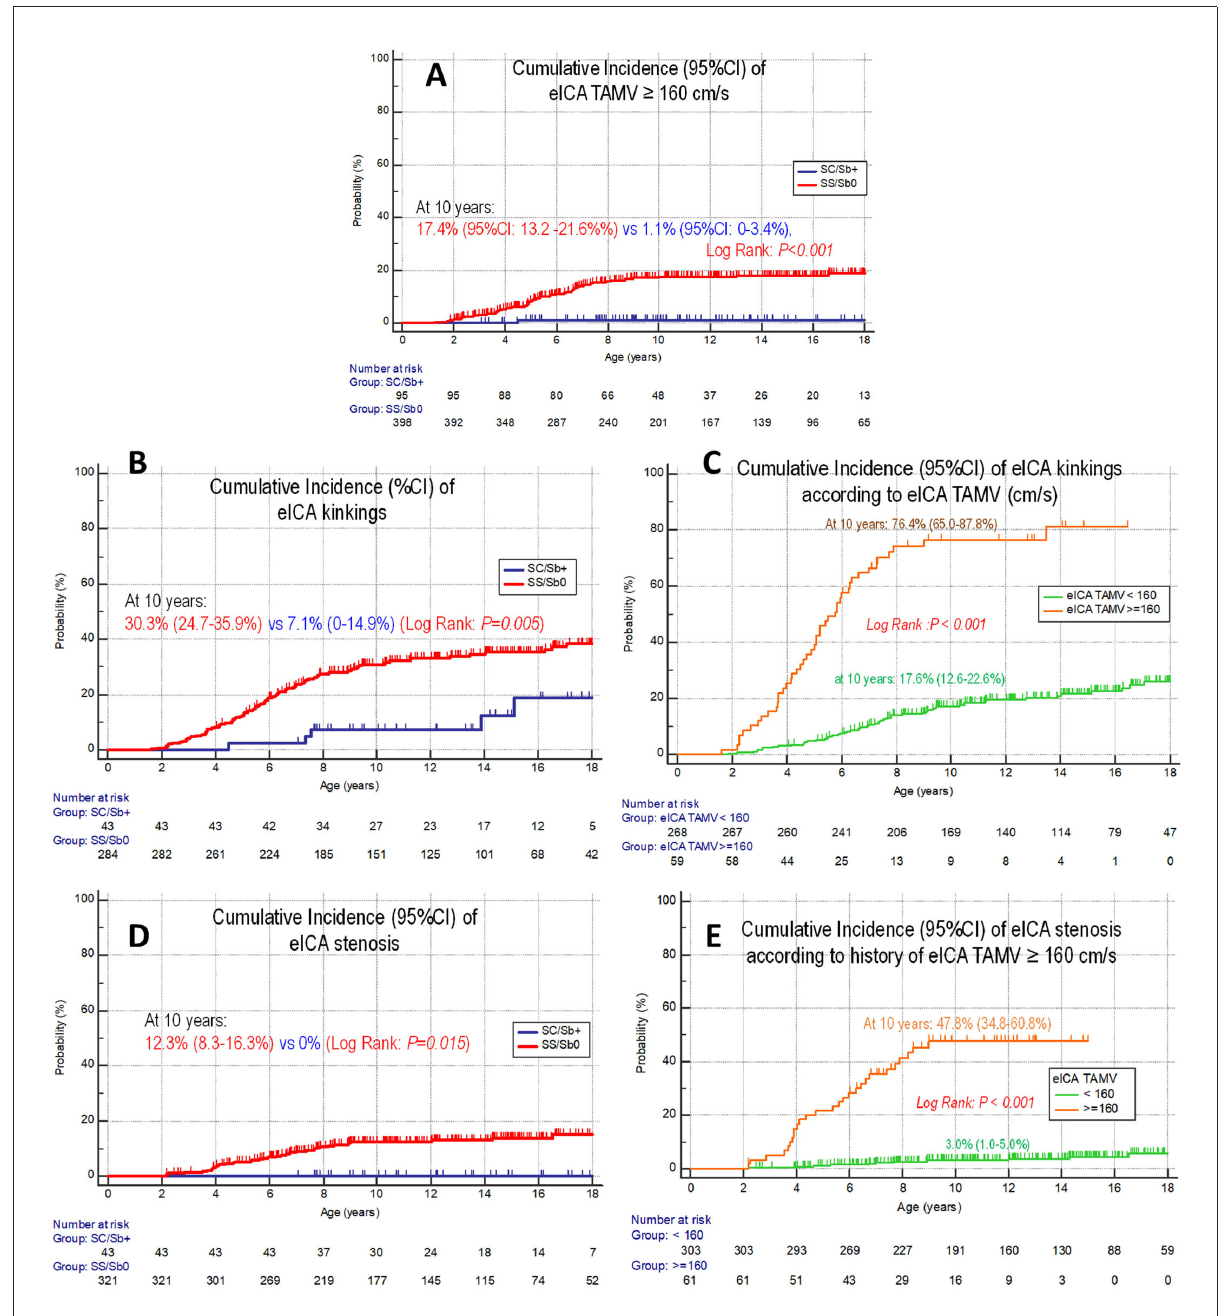
FIGURE3 Comparative cumulative incidence of eICA arteriopathy in SCA vs SC/Sb + children and according to TAMV. (A) eICA ≥ 160 cm/s. (B) eICA kinkings. (C) eICA kinkings according to eICA TAMV ( < or ≥ 160 cm/s). (D) eICA stenosis. (E) eICA stenosis according to eICA TAMV ( < or ≥ 160